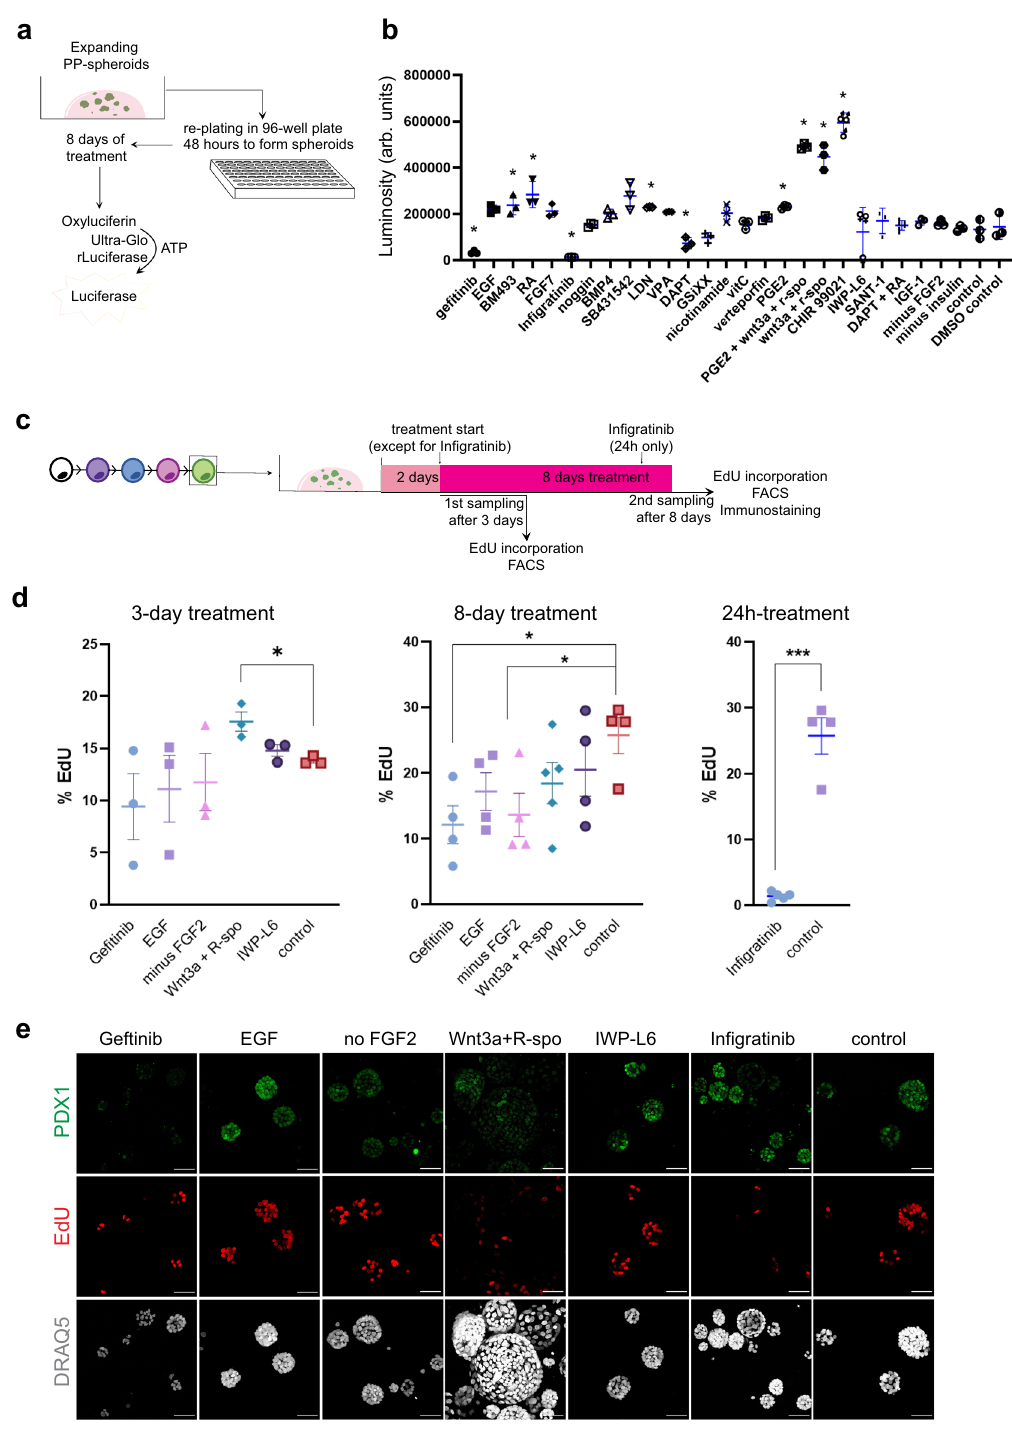
Fig. 6 A developmental model system amenable to screening reveals the importance of EGF and FGF pathways in progenitor proliferation. a PP- spheroids (from HUES4) were passaged into a 96-well plate at normal density and treatments in different conditions started after 2 days. After 8 days of treatment, ATP in each well was measured with a Cell titer-Glo assay, as a proxy for cell numbers. b Luminosity (arb. units) re fl ects the amount of ATP in each well. Results shown as mean ± SD ( n = 3). c For validation, we performed EdU quanti fi cation by fl ow cytometry (PP-spheroids from HUES4 and SBAD3.4) or whole-mount immunostaining (fetal spheres) after 3 or 8 days of treatment. Treatment times were identical to the screening except for In fi gratinib which was used for the last 24 h only. d EdU percentages for different conditions after 3, 8, or 1 (for In fi gratinib) day of treatment, N = 3. Data shown as mean ± SEM. * P < 0.05. P values were determined by a two-sided Mann – Whitney test. e Representative Z-stack projections of whole-mount images showing PDX1, EdU, and DRAQ5 (nuclear stain) in PP-spheroids treated with different conditions. Images are representative of N = 4 validation immunostainings. Scale bar = 50 µ m. See also Supplementary Fig.